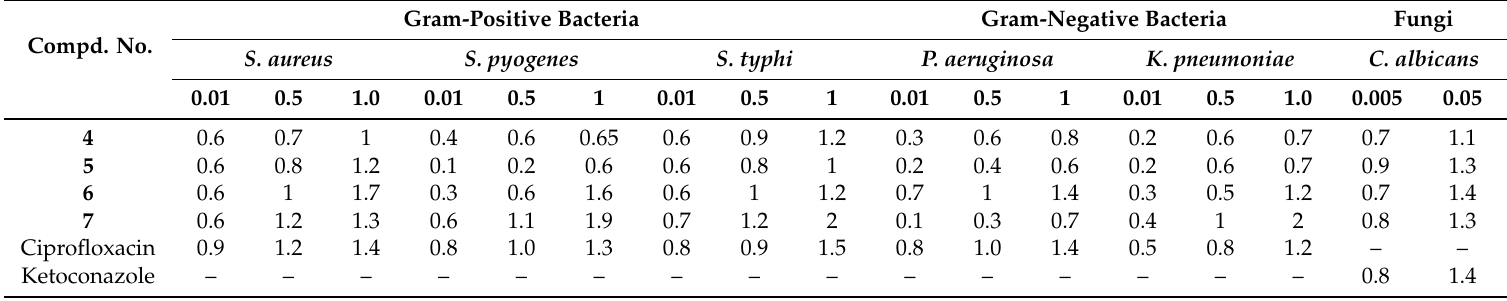
Table 3. Antimicrobial activity expressed as inhibition diameter zones (mm) of the synthesized compounds 4 – 7 at different concentrations ( µ g/mL).